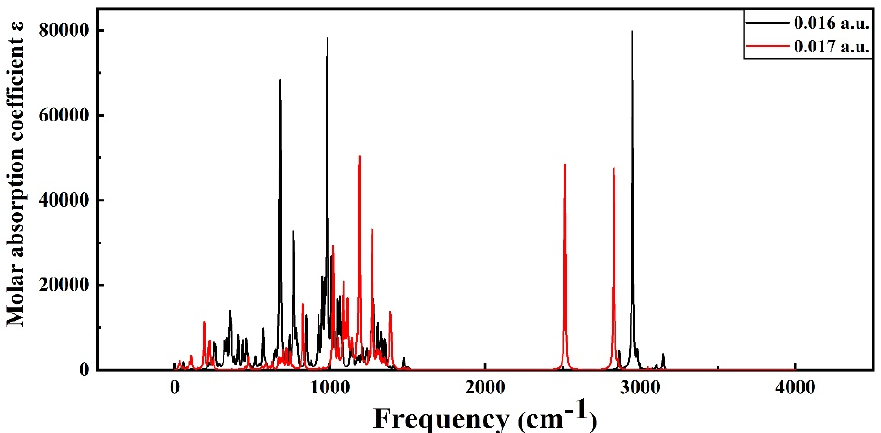
Figure 13. The infrared spectra of PVDF at 0.016 a.u. and 0.017 a.u.